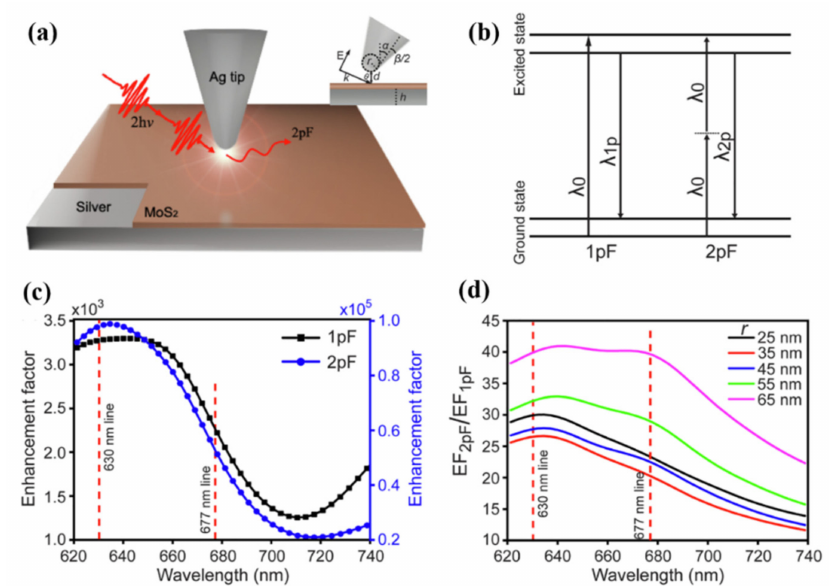
Figure 8. ( a ) Model of the 2 pF process on the Ag tip with the MoS 2 surface. ( b ) Energy level diagrams of excitation and emission processes of 1 pF and 2 pF. ( c ) Comparison in enhancement factors of 1 pF and 2 pF on MoS 2 surface. ( d ) The change in the Ag tip radius couples the SPR and enhances the exciton emission peak at 677 nm [48]. Republished with permission from Ref. [48]. Copyright 2022